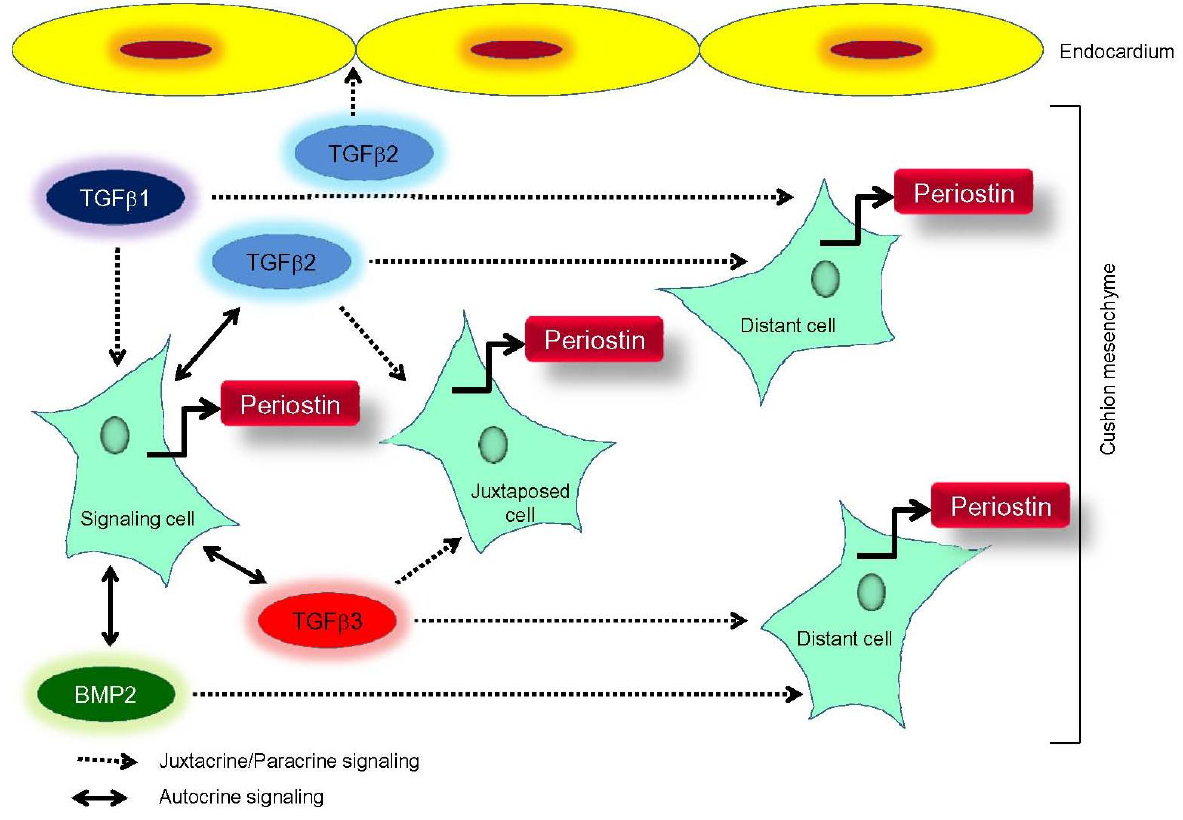
FIGURE 2. The inter-relationship of periostin, TGF  s, and BMP2 in AV cushion remodeling during heart development. In this model, periostin is tied up to a network of TGF  and BMP signaling, which is required for various aspects of valvulogenesis, such as matrix organization, suppression of nonvalvular phenotypes (i.e., ectopic presence of bone and cartilage lineage) and valve differentiation, and valve structure and function in adult hearts (see the text for details). Depiction of the cell type–specific patterns of expression of TGF  and BMP ligand genes and periostin during cushion remodeling is based on published data. Speculation about the role of cell autonomous and nonautonomous action of the TGF  and BMP signaling network on perisotin is also based on published information. Briefly, TGF  2, TGF  3, and BMP2 are predominantly produced in the cushion mesenchyme, where they could engage in autocrine (double-headed arrows) and juxtacrine and paracrine (dotted arrows) signaling to induce Postn during cushion remodeling. Autocrine signaling shows that TGF  or BMP ligands are secreted or produced by and act on the same cell. The term juxtacrine signaling is used here to highlight the action of the secreted TGF  or BMP ligands on the adjacent cell. Paracrine signaling refers to the action of the secreted TGF  or BMP ligands on a distant cell population in the remodeling cushions. Cushion mesenchymal TGF  2 has been shown to have an important paracrine/juxtacrine role in the cessation of cushion EMT. TGF  1 is primarily seen in the cushion endocardium during heart development. Since it can induce Postn in different cell types in vitro , it is possible that TGF  1 could have a paracrine/juxtacrine effect on periostin in the cushion mesenchyme. Consequently, it appears that the cushion mesenchyme have various contingent sources and mechanisms to produce and sustain periostin during valvulogenesis. The model presented here on the molecular regulation of periostin by TGF  1-3 and BMP2 in the context of valvulogenesis is predominantly based on the published association of these molecules and is not proven (see the text for further